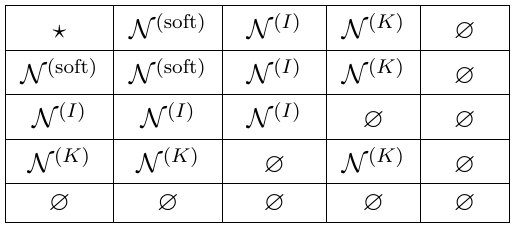
Table 4. Multiplication table for the operation ?